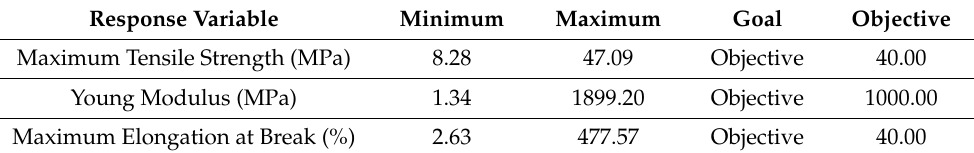
Table 4. Optimization conditions for mechanical properties of the film.